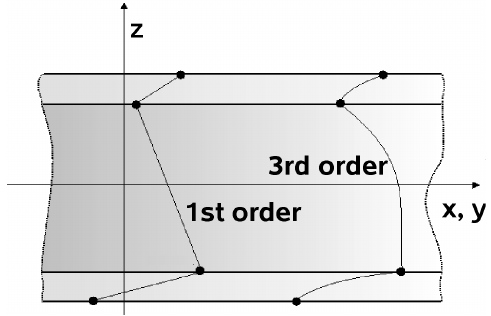
Fig. 3. First- and third-order polynomial approximations for the Layer-Wise approach.